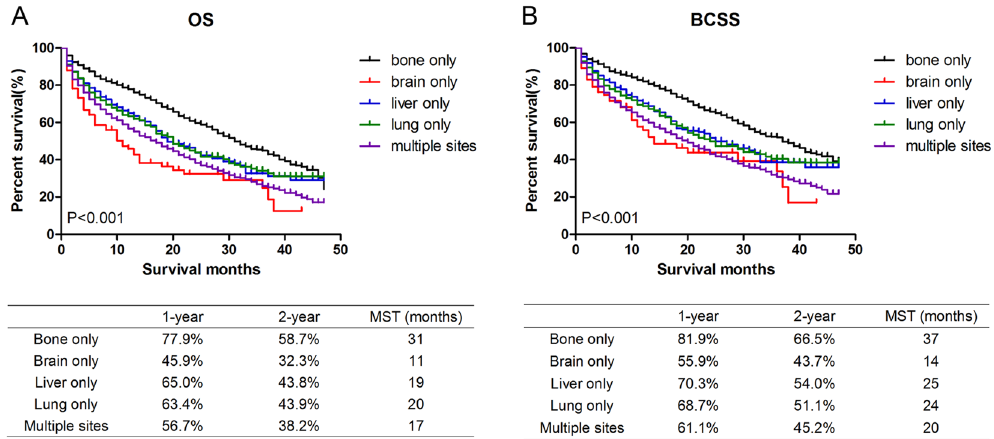
Figure 3. Comparison of survival in breast cancer patients with single or multiple metastatic sites. Kaplan Meier analysis for OS ( χ 2 = 147.7, P < 0.001, Fig. 2A) and BCSS ( χ 2 = 145.7, P < 0.001, Fig. 2B) were shown. The 1-year, 2-year survival rate and median survival time (MST) were listed respectively in the table below the graph. MST: median survival